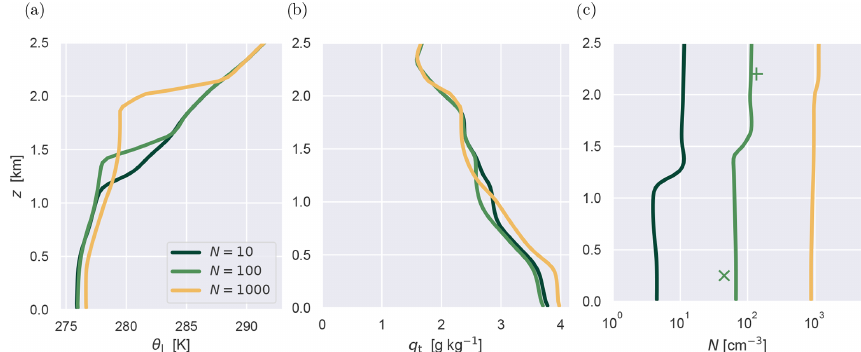
Figure 12. Profiles of (a) liquid water potential temperature θ l , (b) total water specific humidity q t , and (c) the CCN concentration N for the three CCN experiments. Data are time-averaged over the last 48h. Colors represent the initial CCN concentration (cm − 3 ). The modes of the measured concentrations below ( × ) and above ( + ) the cloud layer (shown in Fig. 4) are also indicated, for